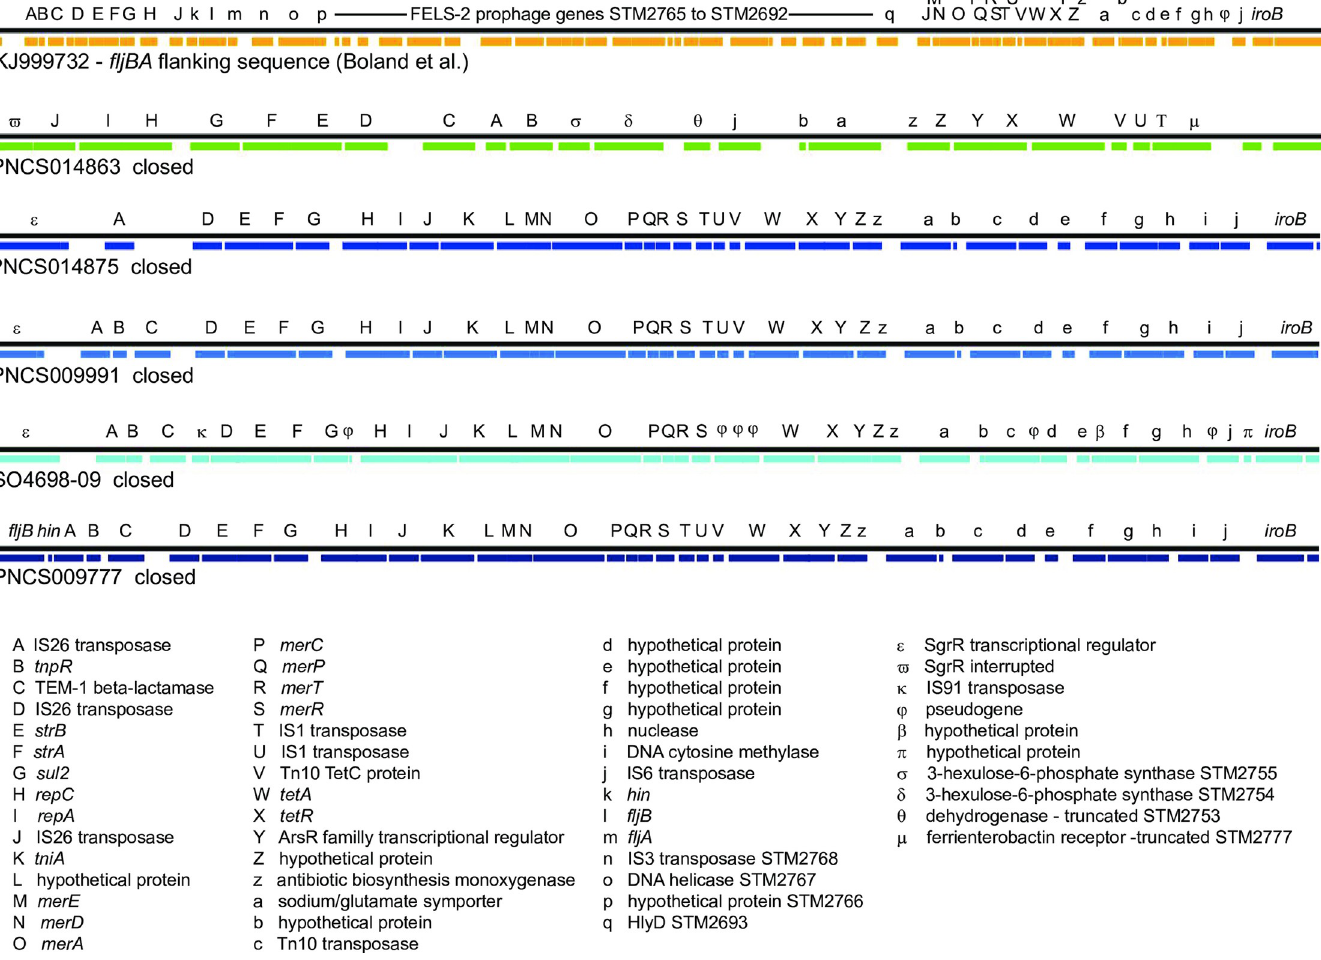
Fig 4. Synteny and variability of the MREL in Salmonella 4,[5],12:i:- closed genomes. In addition to isolates sequenced in this study, strain SO4698-09 and the rearranged locus described by Boland et al. [16] were included. Analysis in GView Server used the “Display genome features” settings. The resulting image files were assembled and annotated in Adobe Illustrator